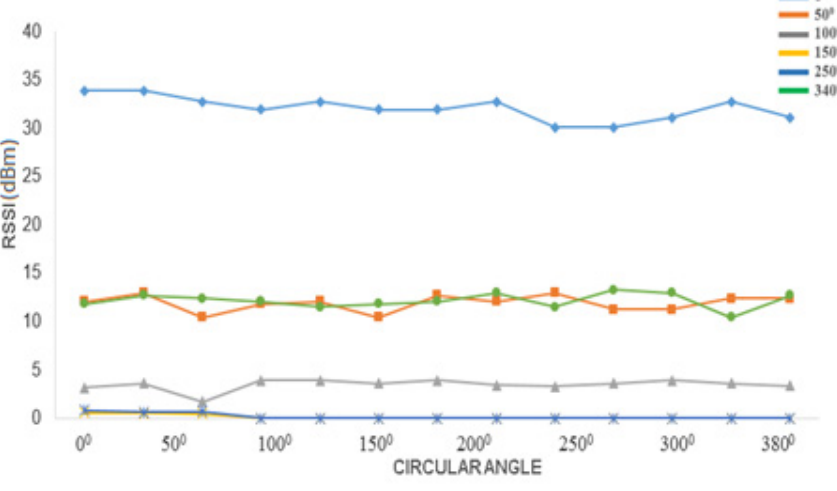
Figure 14. Patch Antenna RSSI.